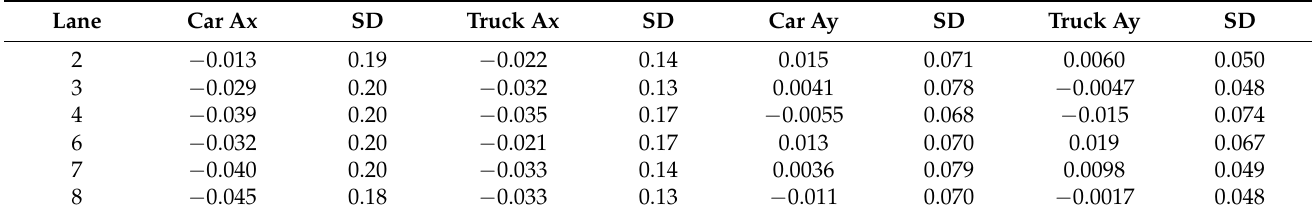
Table A2. The mean and standard deviation of longitudinal and lateral acceleration.